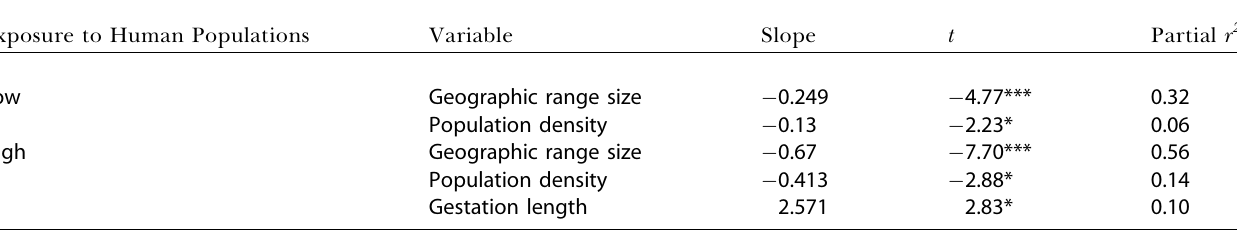
Table 3. MAMs for Carnivore Species with Low and High Exposure to Human Populations Exposure to Human Populations